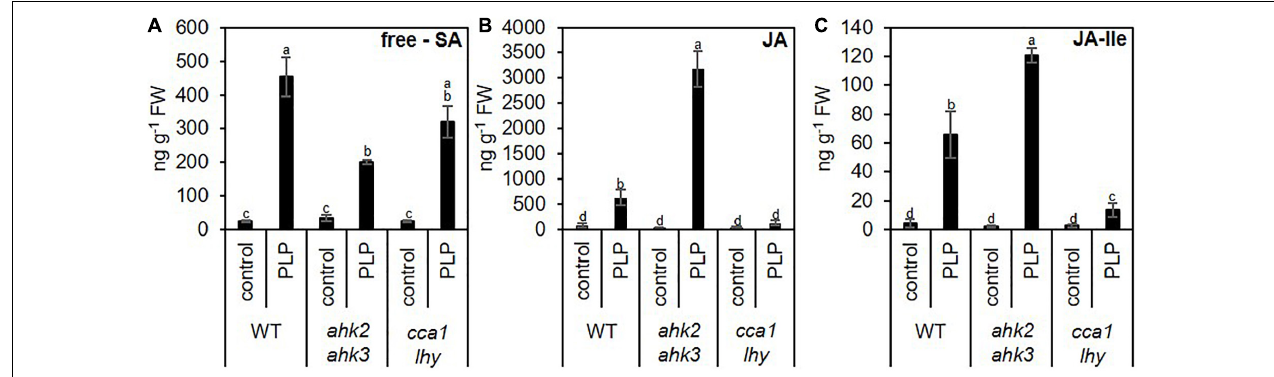
FIGURE 7 | Photoperiod stress alters the levels of phytohormones involved in plant pathogen defense. Five-week-old SD-grown plants (WT, ahk2 ahk3 and cca1 lhy ) were exposed to an extended light period of 32 h followed by a normal SD night. (A) Salicylic acid (SA), (B) jasmonic acid (JA) and (C) jasmonic acid-isoleucine (JA- Ile) were measured at 15 h after the end of the prolonged light period treatment. Error bars represent SE ( n ≥ 7). Letters indicate different statistical groups ( p ≤ 0.05) as determined by a multiple Welch t -test with FDR